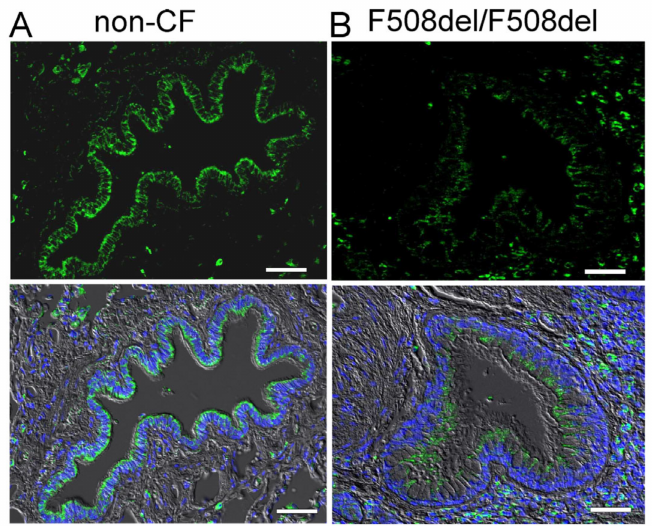
Figure 1. Apical expression of SLC26A9 in human non-CF but not CF superficial airway epithelium. Immunohistochemistry of SLC26A9 (green fluorescence) expressed in non-CF (( A ) wt-CFTR/wt- CFTR) and CF (( B ) F508del-CFTR/F508del-CFTR) superficial airway epithelium. Reduced expression and intracellular localization of SLC26A9 is found in CF lungs. Bar = 50 µ m. Nuclei were stained by